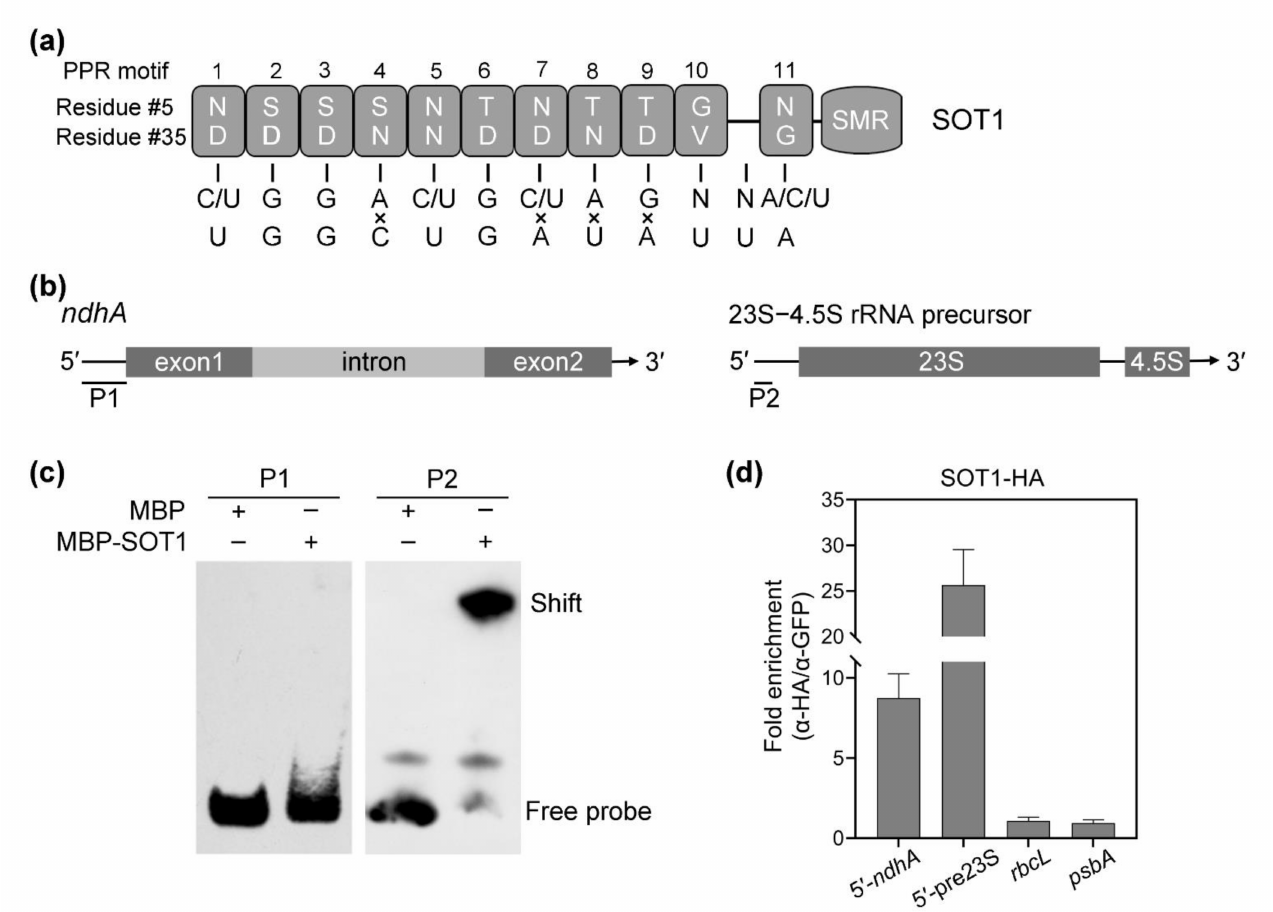
Figure 4. SOT1 binds the 5 (cid:48) region of the ndhA transcripts in vivo. ( a ) Schematic illustration of the PPR motif in SOT1 and its alignment with the predicted binding site in the 5 (cid:48) region of the ndhA transcripts. Each box indicates the amino acid residues at positions 5 and 35 of an individual PPR motif. The potential nucleotide targets of PPR motifs are shown below. ( b ) Schematic representation of the domain structures of ndhA mRNA and the 23S − 4.5S rRNA precursor. The positions of probes P1 and P2, which were subjected to electrophoretic mobility shift assays (EMSAs), are shown below the models. ( c ) EMSA showing that SOT1 alone exhibits little binding activity to the 5 (cid:48) ends of ndhA transcripts in vitro. A total of 150 nM recombinant MBP and MBP-SOT1 proteins were incubated with 10 nM biotin-labeled probes (P1 and P2). Three independent experiments were performed, and one representative experiment is shown. ( d ) RNA coimmunoprecipitation assays identify that SOT1 binds the 5 (cid:48) region of ndhA transcripts in vivo. The intact chloroplasts were isolated from 12-day- old sot1-3 complemented plants ( sot1-3/35S:SOT1-HA ). The chloroplast extracts were subjected to immunoprecipitation against HA and GFP antibodies. SOT1 was reported to bind the 5 (cid:48) ends of the 23S − 4.5S rRNA precursor [22,23]; therefore, this interaction served as a positive control. The sample immunoprecipitated with the GFP antibody served as a negative control. The relative RNA-enrichment levels were determined using qPCR. 5 (cid:48) - ndhA and 5 (cid:48) -pre23S indicate the 5 (cid:48) ends of ndhA transcripts and 23S − 4.5S rRNA precursor, respectively. Mean values ± SD of the triplicate replicates are